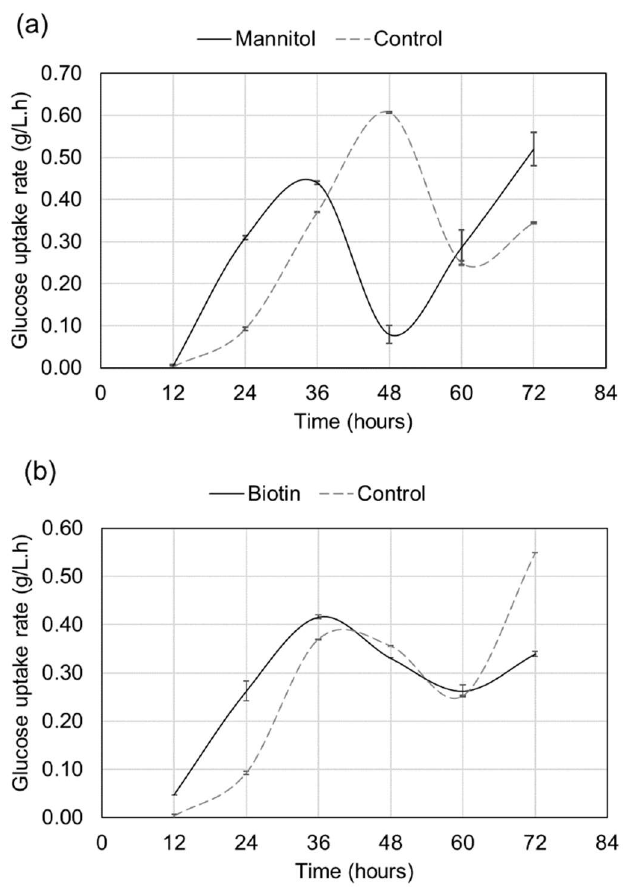
Figure 3. Time course of glucose consumption by ATCC 26185 culture upon ( a ) mannitol (1 g/L) and ( b ) biotin (0.15 mg/L) supplementation at 0 h of fermentation. The data are expressed as the mean ± SD of duplicate experiments.